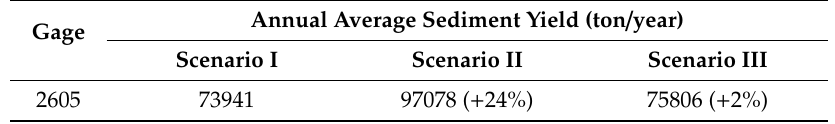
Table 9. Comparison of annual average sediment yield sediment yield values (1990 to 2016).